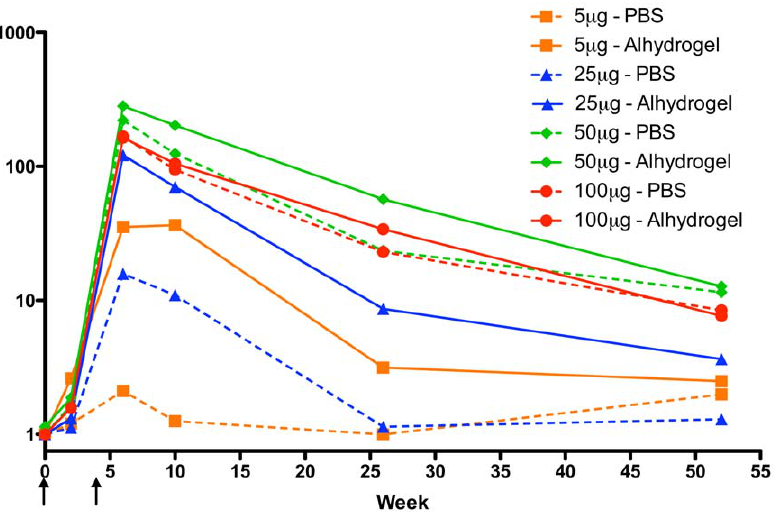
Figure 4. Geometric mean concentration of anti-rPA antibodies over time. The concentration of anti-rPA antibodies was assessed by ELISA at weeks 0, 2, 6, 10, 26, and 52 over the course of the entire study. Arrows indicate when the two injections occurred.